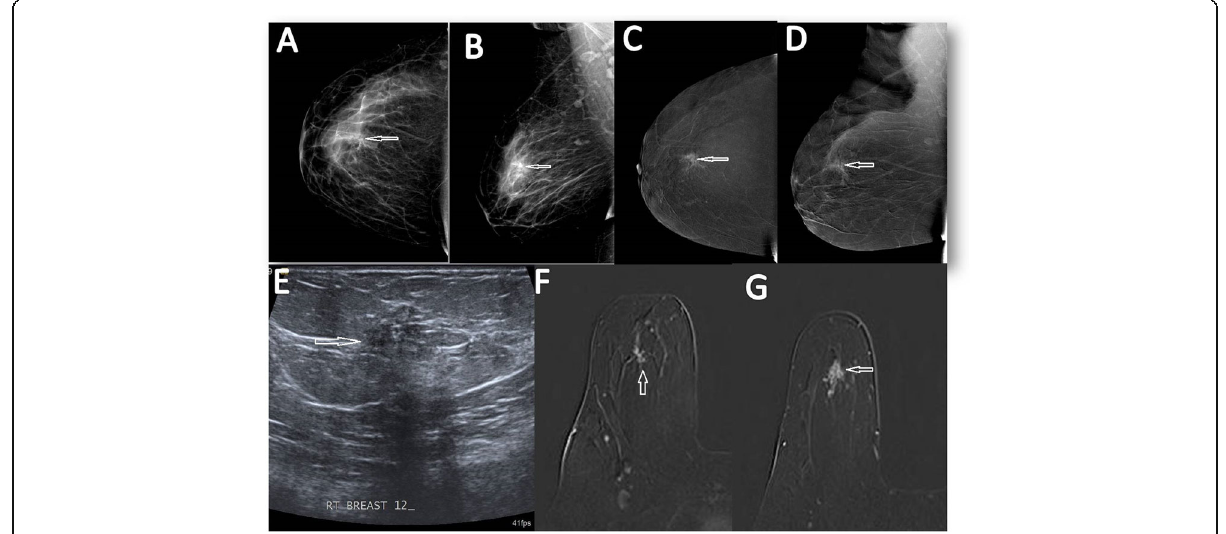
Fig. 1 Female patient 55 years old, she was complaining of left breast mass. On ultrasound ( a ), there was a hypoechoic mass at 9 o ’ clock with slight an irregular margin (arrow). On T1 MRI ( b ), the lesion appears hypointense with irregular outlines (arrow). On TIRM MRI ( c ), the lesion shows